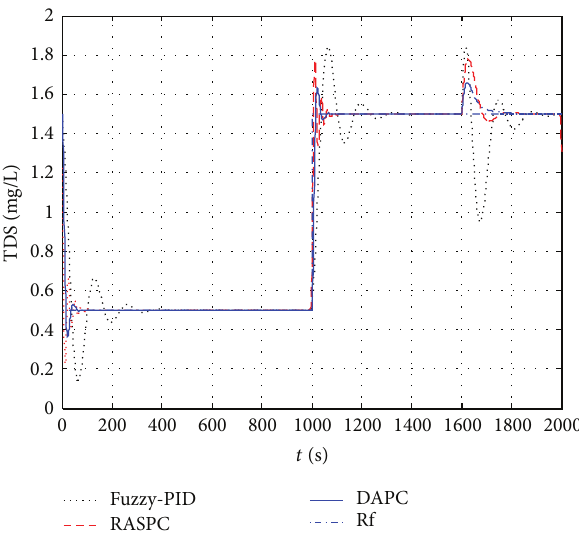
Figure 7: The response comparison in the presence of disturbance after the parameters